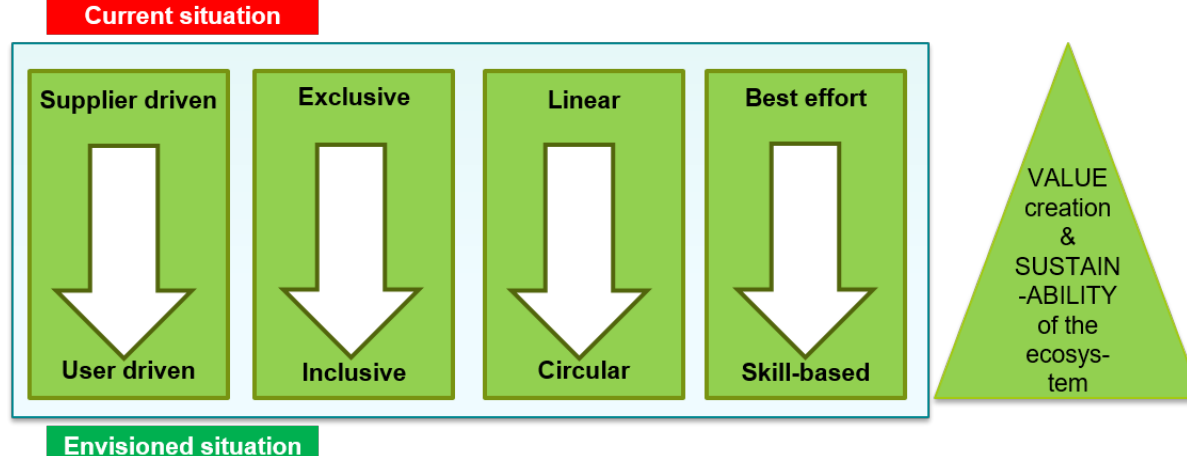
Figure 1: Towards value-creating and sustainable open data